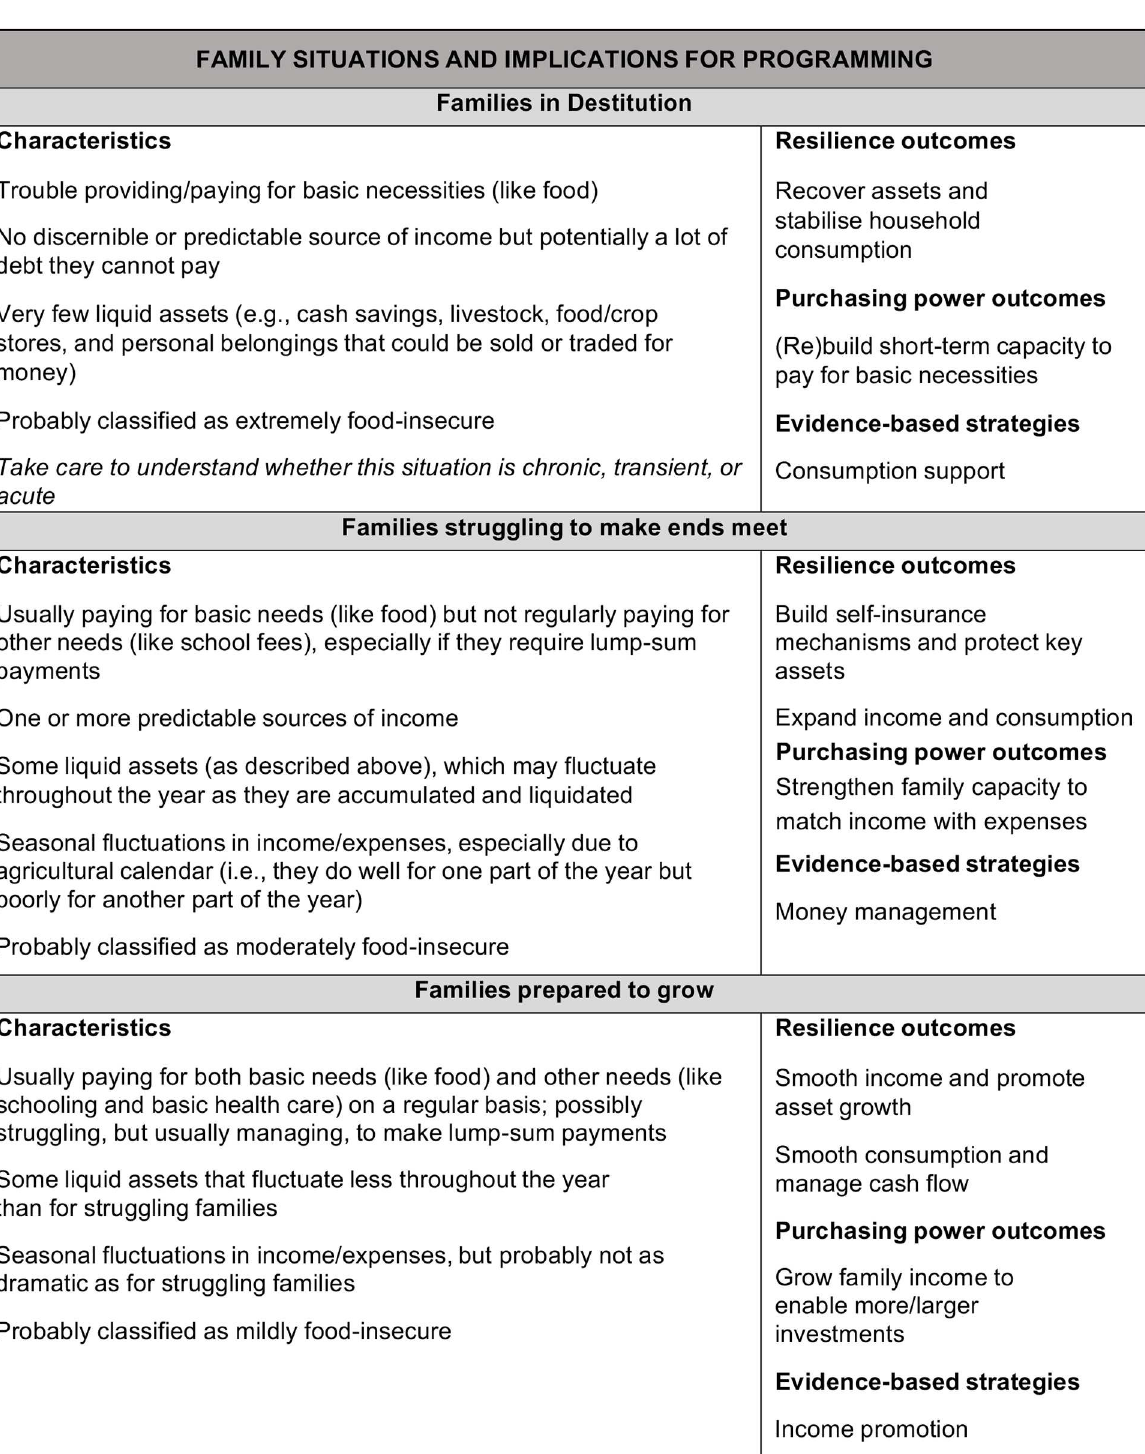
Fig 1. PEPFAR economic strengthening categories (see p. 47 in [2]).